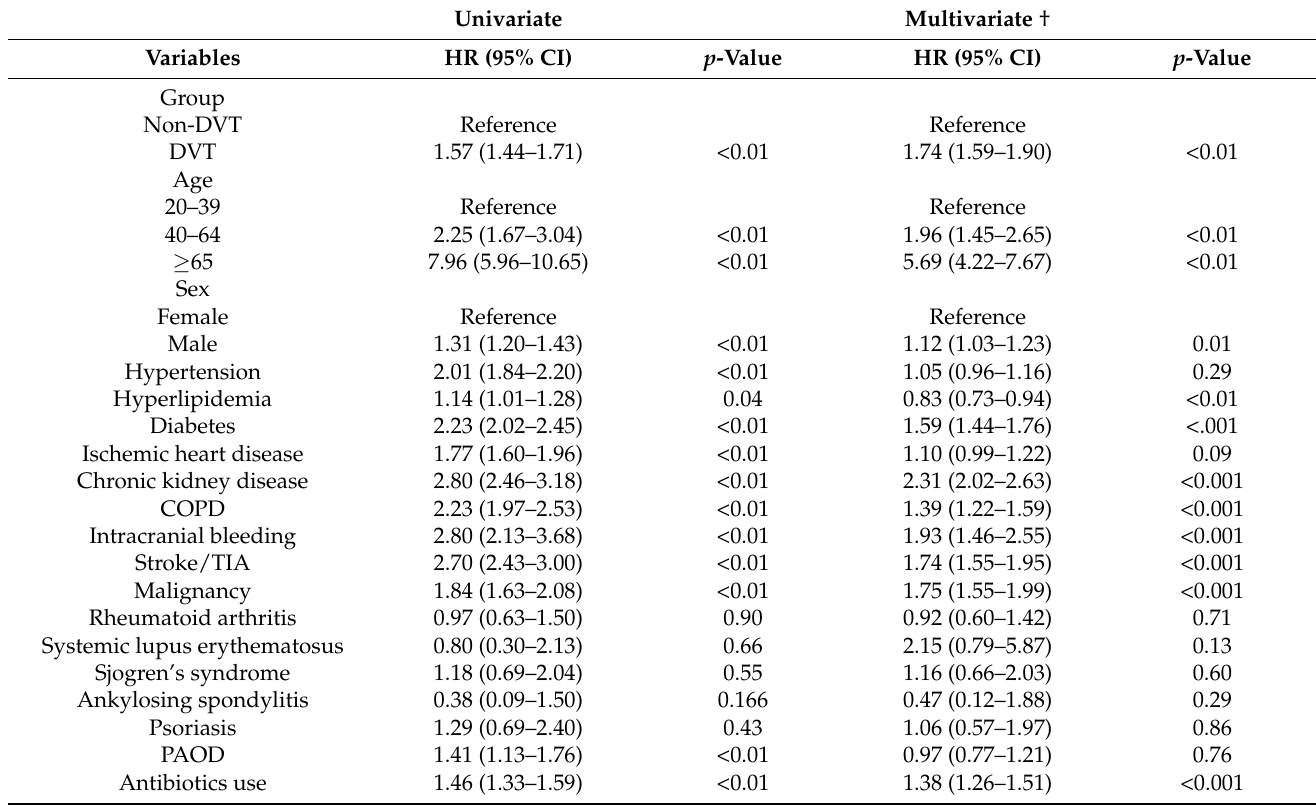
Table 3. Cox proportional hazard model analysis for risk of sepsis.